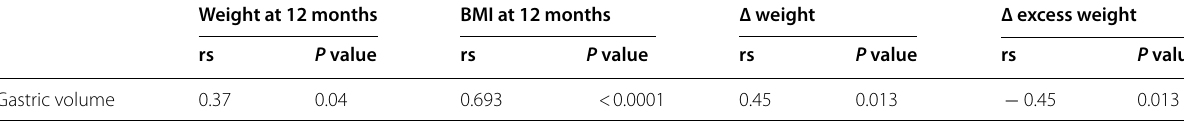
rs Spearman rank correlation coefficient A significant positive association was found among gastric size and the weight loss at 12 months ( P value < 0.0001) and among gastric size and ∆weight ( P